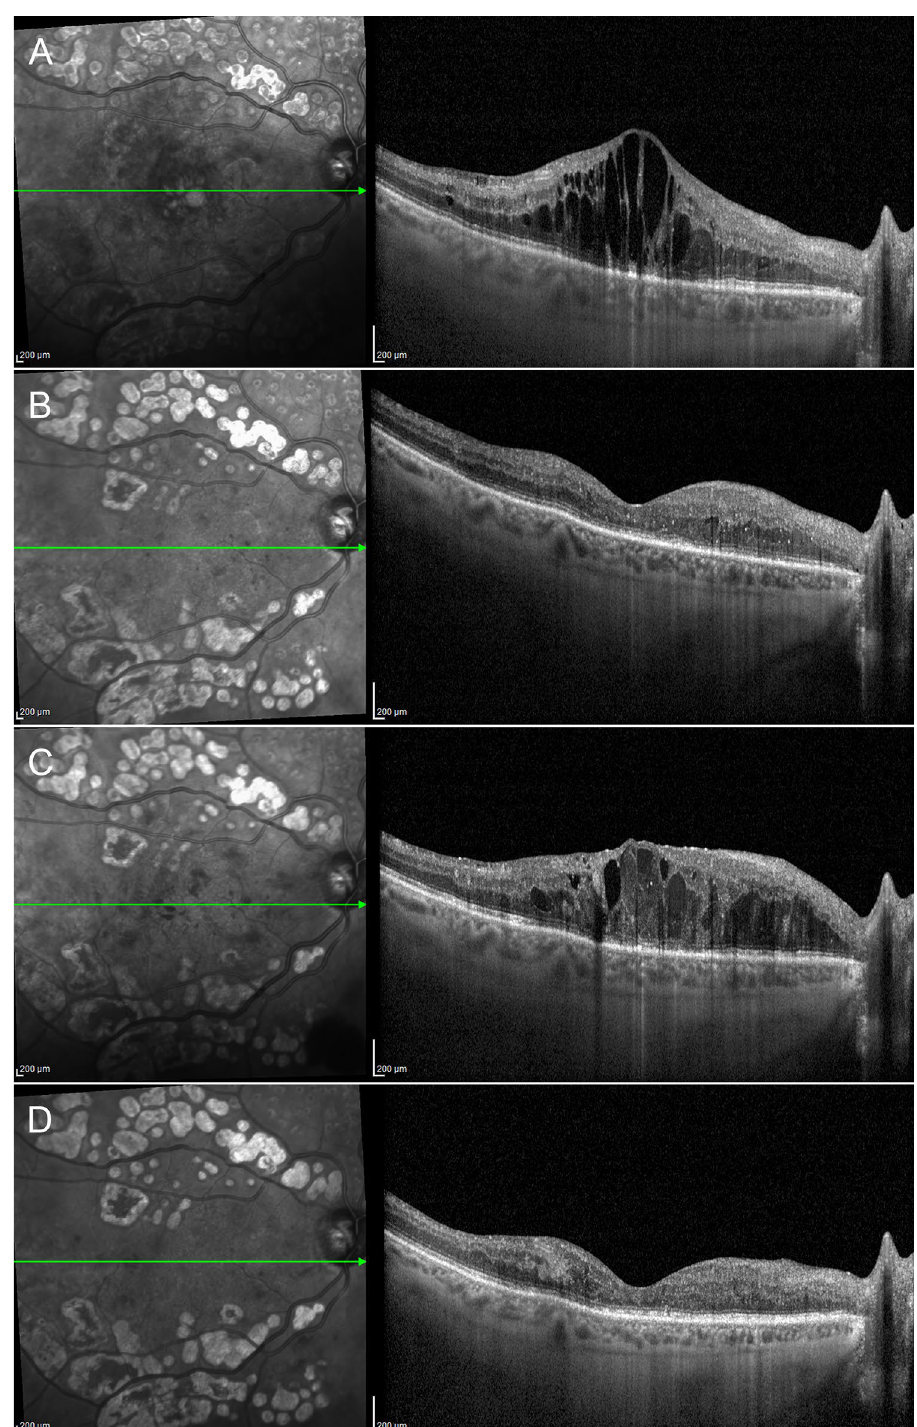
Figure 3. Foveal eversion Pattern 1b. Baseline examination shows a DME with foveal eversion and multiple thin transretinal mixed reflectivity central lines ( A ). Fluid reabsorption is registered after treatment ( B ) (6-month F/U) and DME shows recurrence during the follow-up, with disorganization of the retinal layers in the foveal region ( C ) (9-month F/U). At the last follow-up, DME has regressed, and evident DRIL, attenuated ellipsoid zone and thinning of the outer nuclear layer are detected ( D